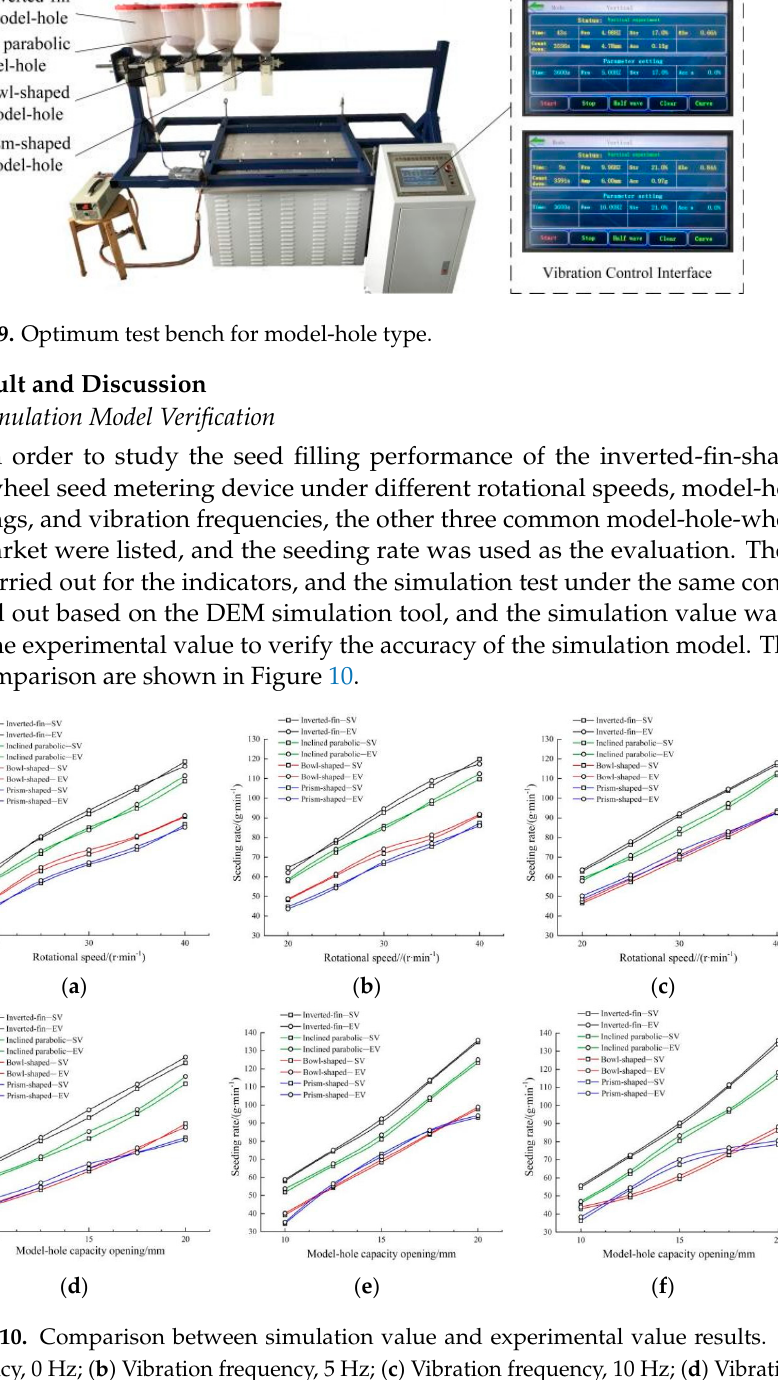
0 Hz; ( e ) Vibration frequency, 5 Hz; ( f ) Vibration frequency, 10 Hz.